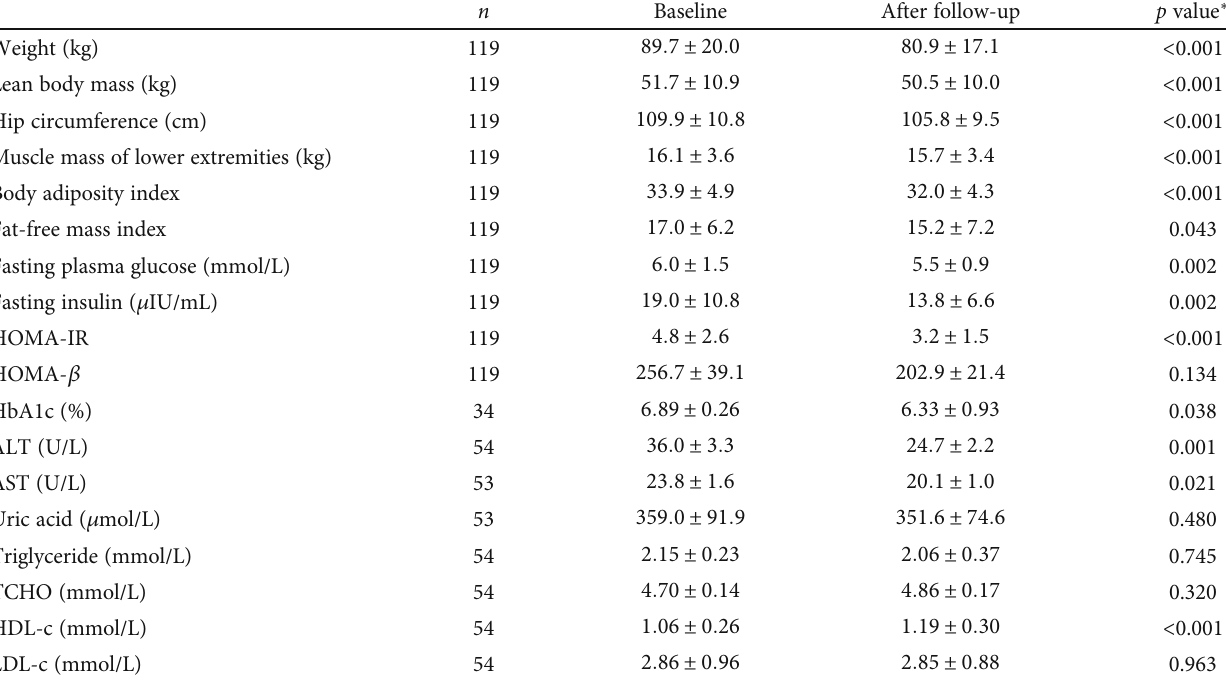
Table 2: Variation of anthropometric and metabolic indicators after treatment of obesity MDT. n Baseline After